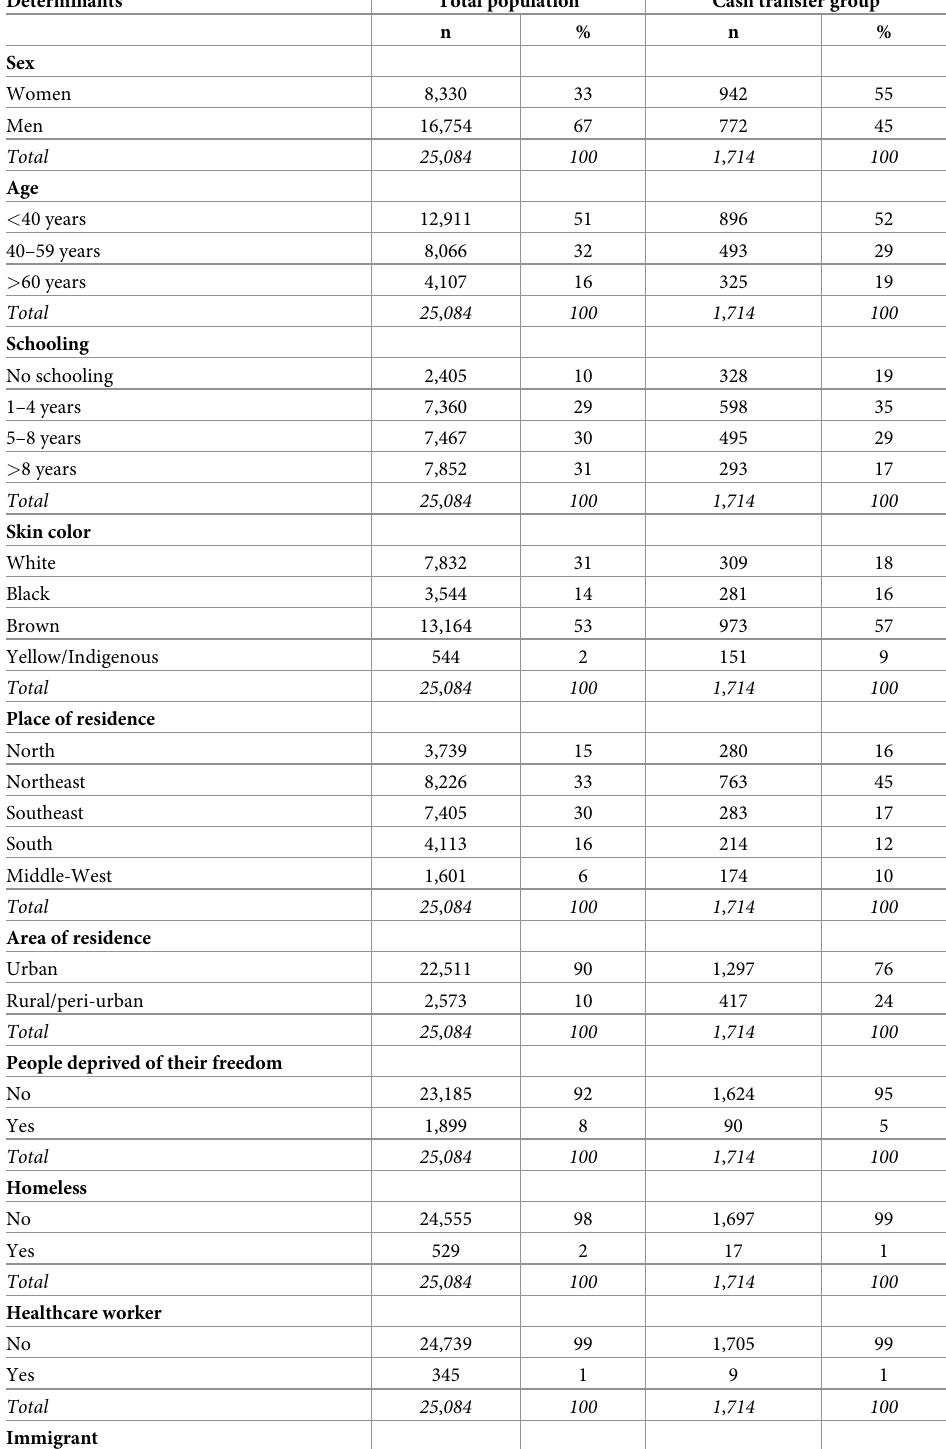
Table 1. Distribution of sociodemographic determinants of tuberculosis among people from the Brazilian Notifi- able Disease Information System database (SINAN), 2015.